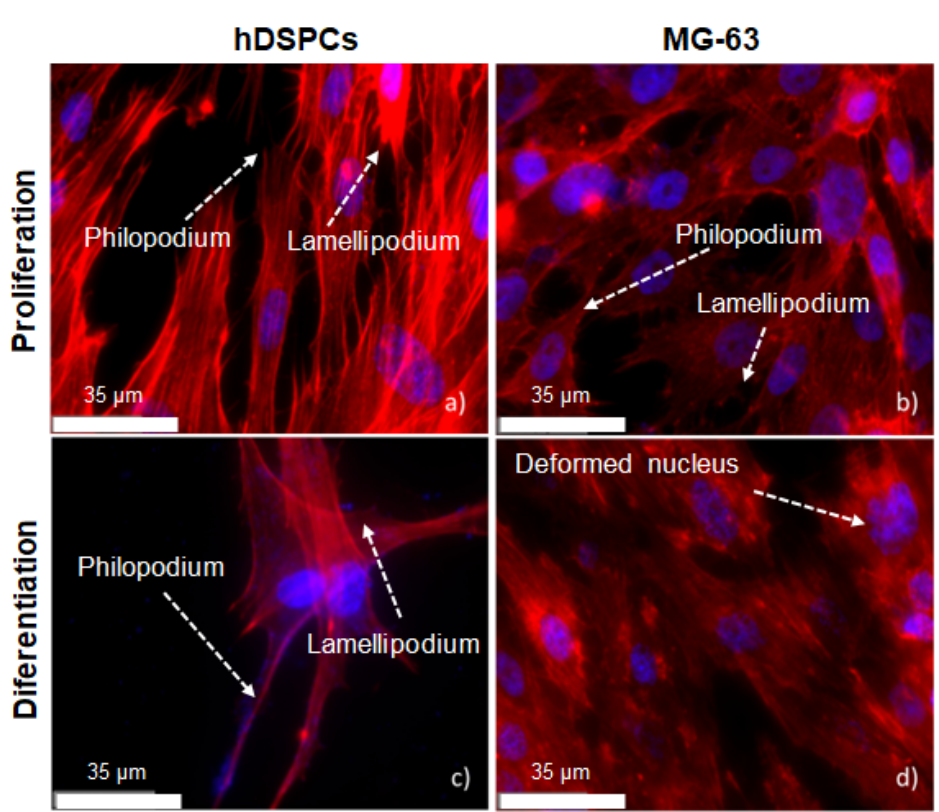
Figure 16. Immunocytochemical staining for F-actin (in red) and nuclei counterstained with DAPI in the hDPSCs and MG-63 cultured in conventional medium (first line) ( a , b ) and differentiation medium (second line) ( c , d ). They were all cultivated on as-cast TNZT surfaces.